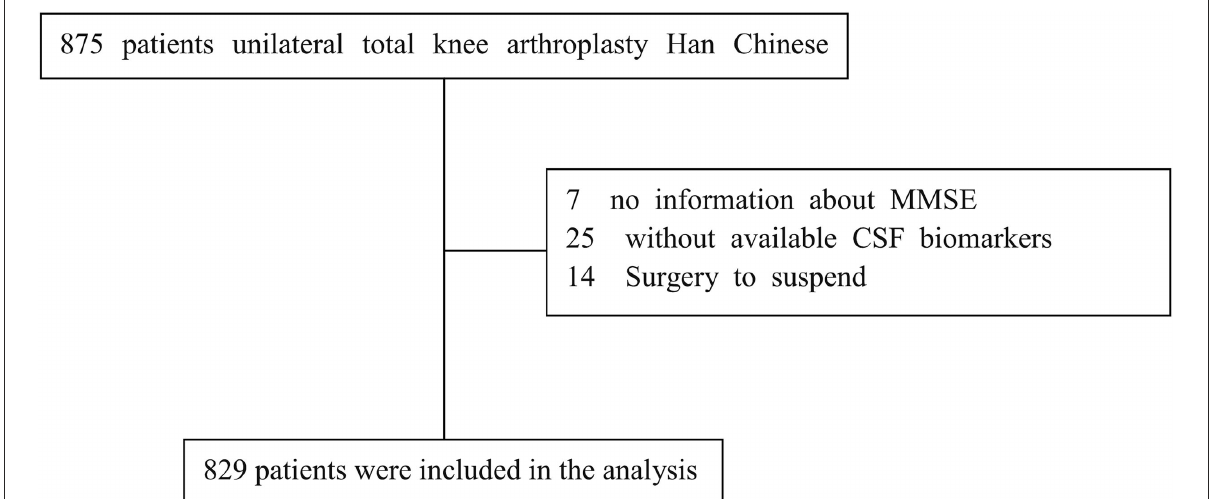
FIGURE1 A flow diagram showed selection of eligible patients and the enrollment